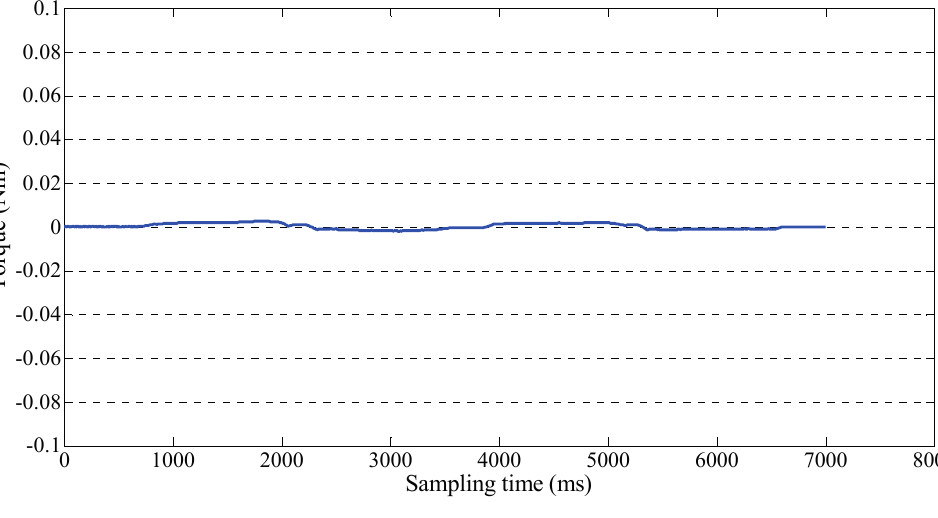
Figure 14. Output torque of the master